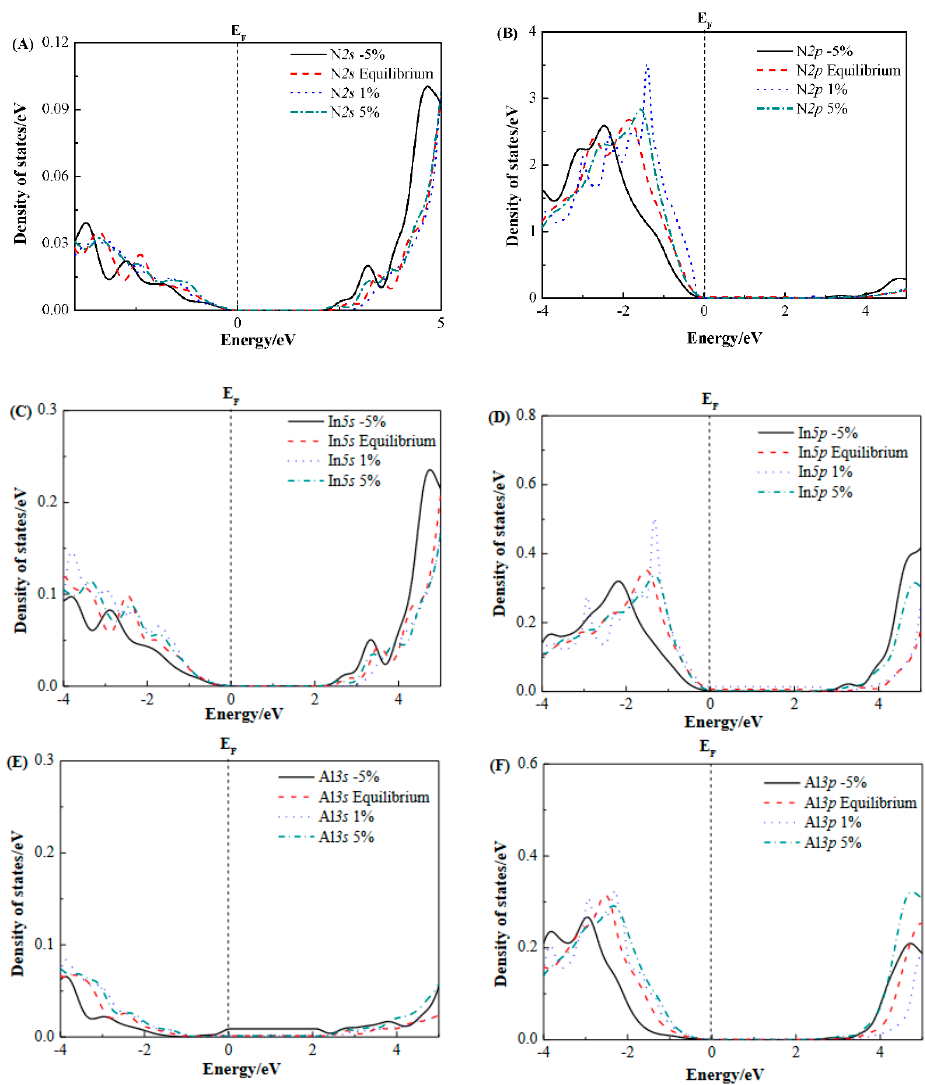
Figure 5. Partial density of states of freely relaxed In 0.5 Al 0.5 N under different biaxial strains for ( A ) N2 s , ( B ) N2 p , ( C ) In5 s , ( D ) In5 p , ( E ) Al3 s , ( F ) Al3 p electrons.